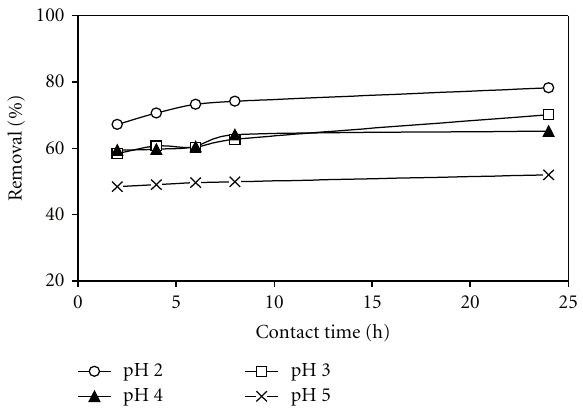
F 6: Basic dye adsorption capacity of PC-N as a function of contact time (adsorbent dosage, 500 mg per 100 mL; dye ). concentrations, 50 mg L −1